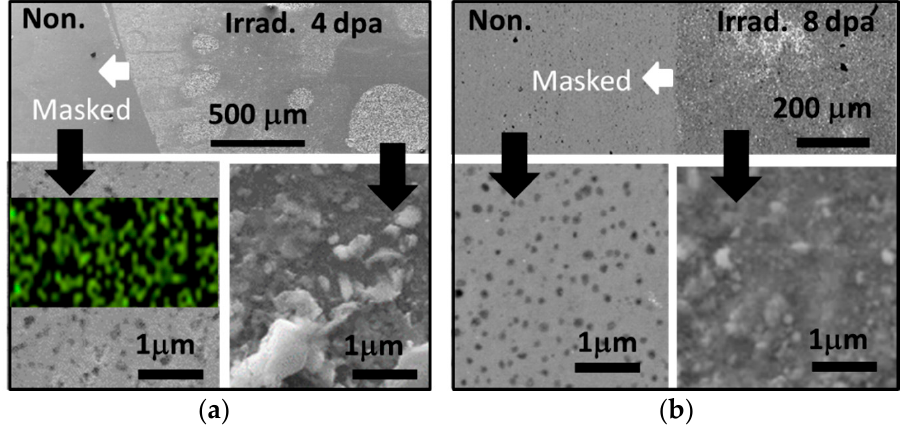
Figure 3. Surface SEM images after corrosion tests for the irradiated 316L specimens. Upper images were observed on the boundary area irradiated at ( a ) 4 dpa and ( b ) 8 dpa. The mapping image from Ni is inserted in the masked area shown in ( a ). The black dots correspond to the Ni-depleted areas and behave similarly for both ( a , b ).